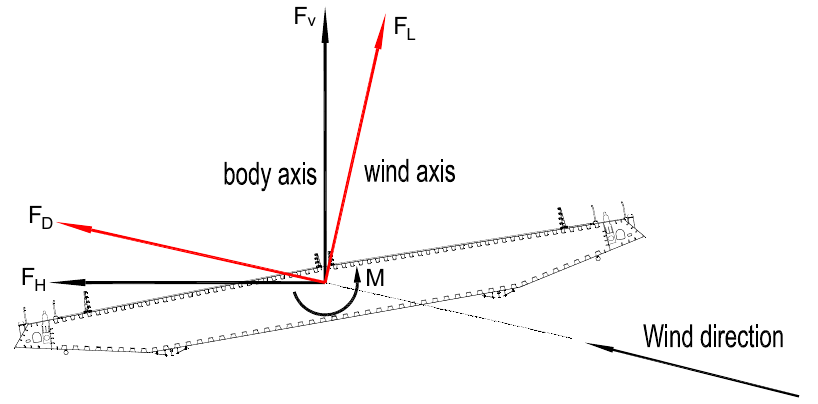
Figure 7. Aerodynamic forces acting on the deck.